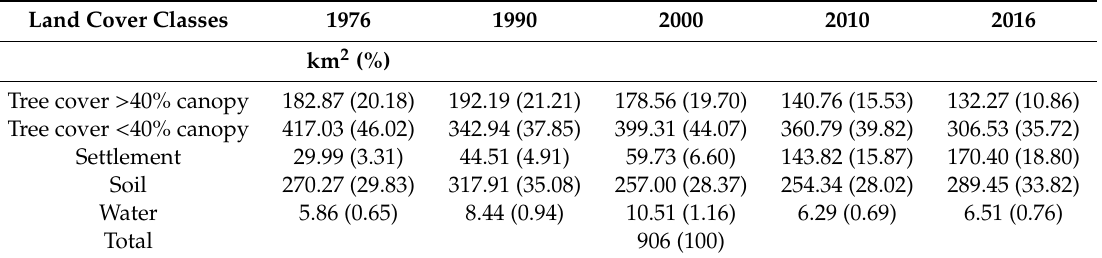
Table 4. Land cover 1976, 1990, 2000, 2010, and 2016 assessment based on satellite